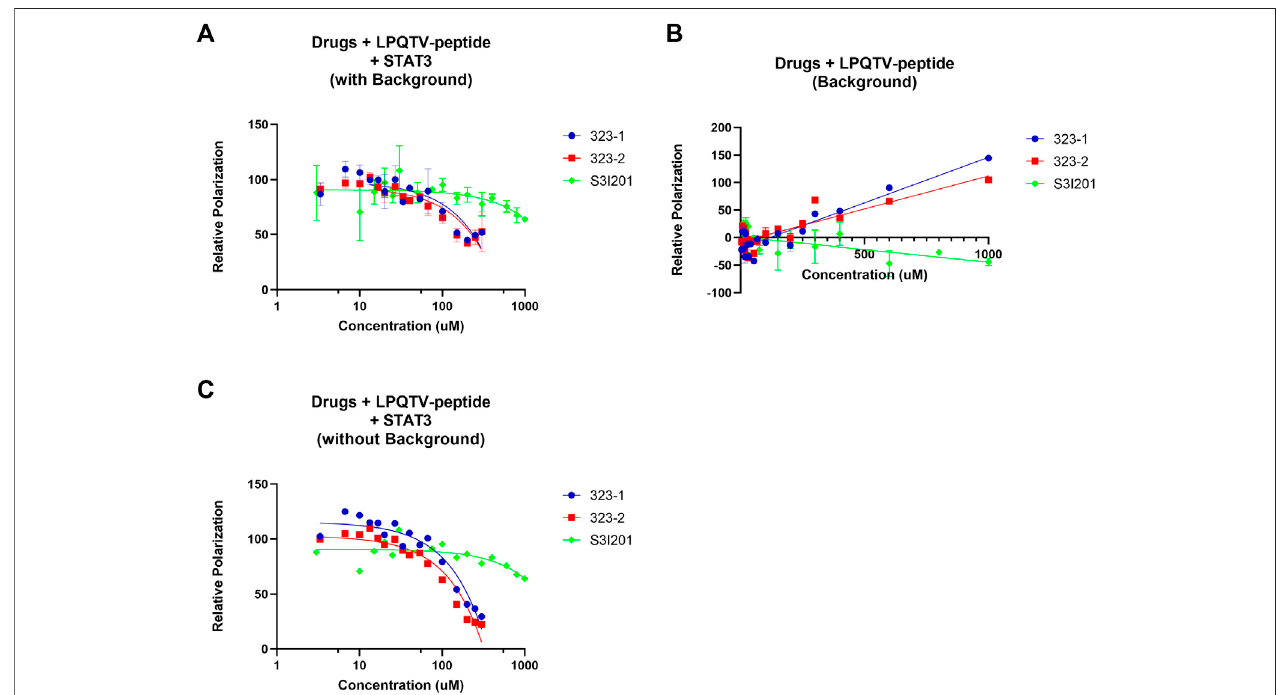
FIGURE4| Fluorescencepolarization(FP)assaysidenti fi ed323sasdirectSTAT3SH2domainbinders. (A) Fluorescencepolarization(FP)analysisofthebindingof 10 nM GpYLTQTV-NH 2 and 150 nM human STAT3 protein with increasing concentration of drugs. (B) Different doses of drugs combined with only 10 nM GpYLTQTV- NH 2 (B) or 150 nM human STAT3 protein. (C) FP analysis of background deduction by application of 10 nM GpYLTQTV-NH2 and increasing doses of drugs. Control was set as 1% DMSO. Data are representative of two independent